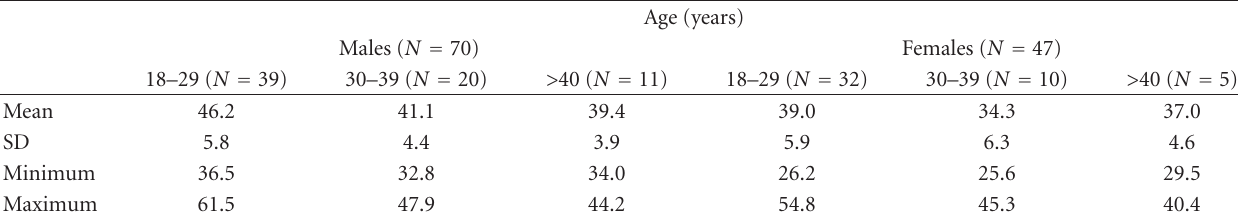
Table 2: Descriptive values for V O